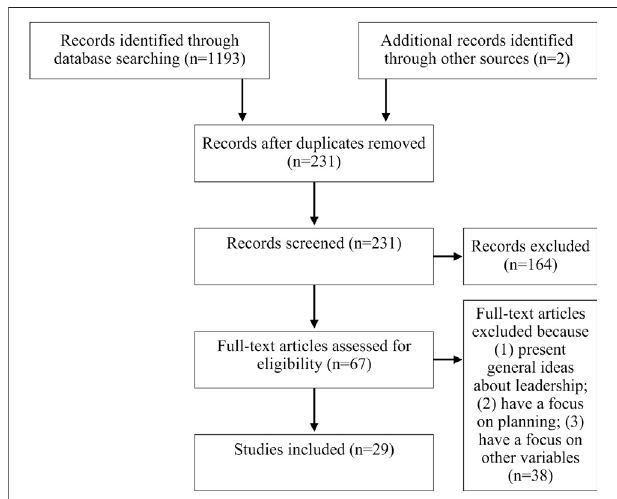
FIGURE 1 | PRISMA chart outlining the study selection process.